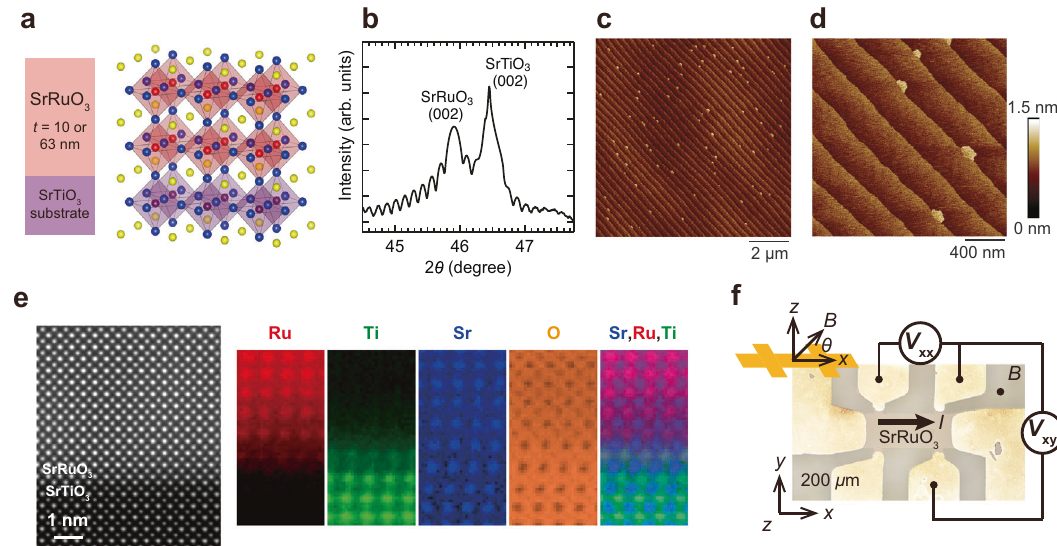
Fig. 1 Sample characteristics and Hall bar device of SrRuO 3 . a Schematic of the sample and crystal structures of the SrRuO 3 fi lms on a SrTiO 3 substrate 105 . In the schematic crystal image, yellow, blue, red, and purple spheres indicate strontium, oxygen, ruthenium, and titanium, respectively. b XRD θ -2 θ scan of the SrRuO 3 fi lm with t = 63 nm. c AFM image of the SrRuO 3 fi lm with t = 63 nm. d Magni fi ed image of c . e Cross-sectional high-angle annular dark fi eld scanning transmission electron microscopy (HAADF-STEM) image of the SrRuO 3 fi lm with t = 63 nm along the [100] axis of the SrTiO 3 substrate. EELS-STEM images (from left to right) for the Ru- M 4,5- (red), Ti- L 2,3- (green), Sr- M 3 - (blue), O- K -edge (orange), and a color overlay of the EELS-STEM images for Sr, Ru, and Ti. f Optical microscope image of a Hall bar device. The current fl ows along the x direction, and the longitudinal and Hall voltage were measured using the V xx and V xy terminals. The upper left inset shows the arrangement of the Hall bar device and the magnetic fi eld B